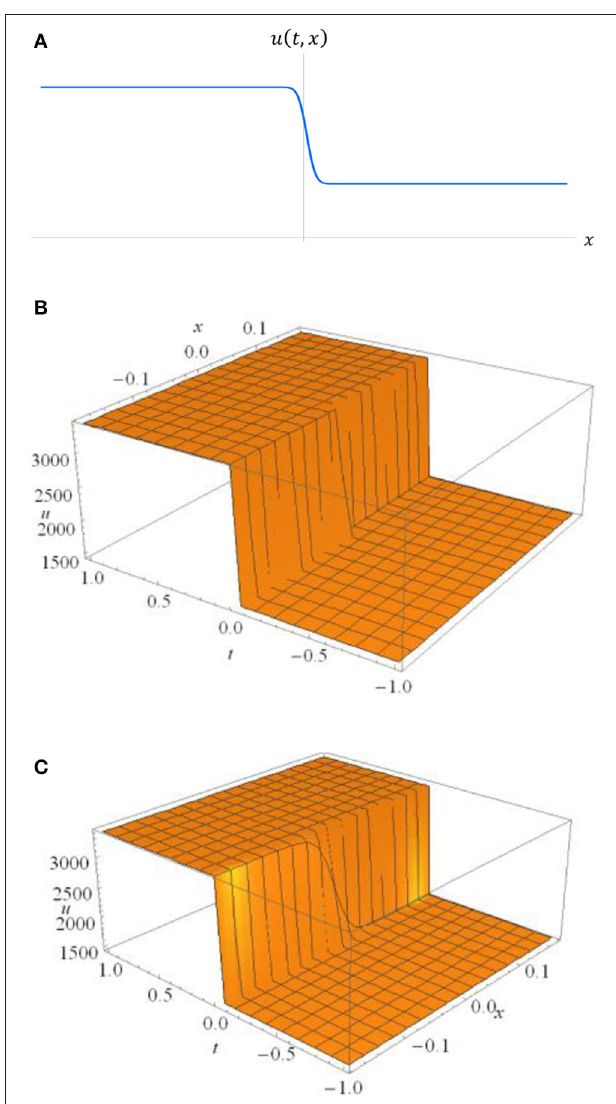
FIGURE 1 | (A) Shock-wave solution illustrating the discontinuity between the incoming (horizontal) wave velocity of u ( t , x ) = v I = 3,415m/s, and the outgoing velocity of u ( t , x ) = v F = 1461.794m/s—where v I and v F are each taken to be constant for −∞ ≤ x ≤ 0 and 0 ≤ x ≤ ∞ , in this case, respectively. In the case of a spatially fixed-size skull, there are actually three intervals, whereby −∞ ≤ x ≤ 0, 0 ≤ x ≤ x R and x R ≤ x ≤ ∞ , each representing v I = 3,415m/s, v F = 14671.794m/s and then v I = 3,415m/s again, respectively. Note that, in this graph, the vertical-axis represents general (non-linear) velocity, u ( t , x ) , whilst the horizontal-axis generally represents distance, x meters. (B) . Shock-wave solution, with a vanishingly-small diffusion coefficient, in 3-dimensions over the spatio-temporal ranges of − 0.176 ≤ x ≤ 0.176m and − 1 ≤ t ≤ 1s. If the solution is plotted with x and t axes reversed, Mathematica simply rotates the plot by 90 ◦ . As characteristic of plotting all shock-waves, its motion is essentially illustrated as propagating with respect to both the x - and t -axes, with a sharp discontinuity at x = 0 and t = 0, primarily. (C) Shock-Wave solution, with a moderately-small diffusion coefficient, in 3-dimensions over the spatio-temporal ranges of − 0.176 ≤ x ≤ 0.176m and − 1 ≤ t ≤ 1s. As in (B) , if the solution is plotted with x and t -axes reversed, Mathematica simply rotates the plot by 90 ◦ . As is characteristic of the plotting of all shock-waves its motion is, again, essentially illustrated as propagating with respect to both the x - and t